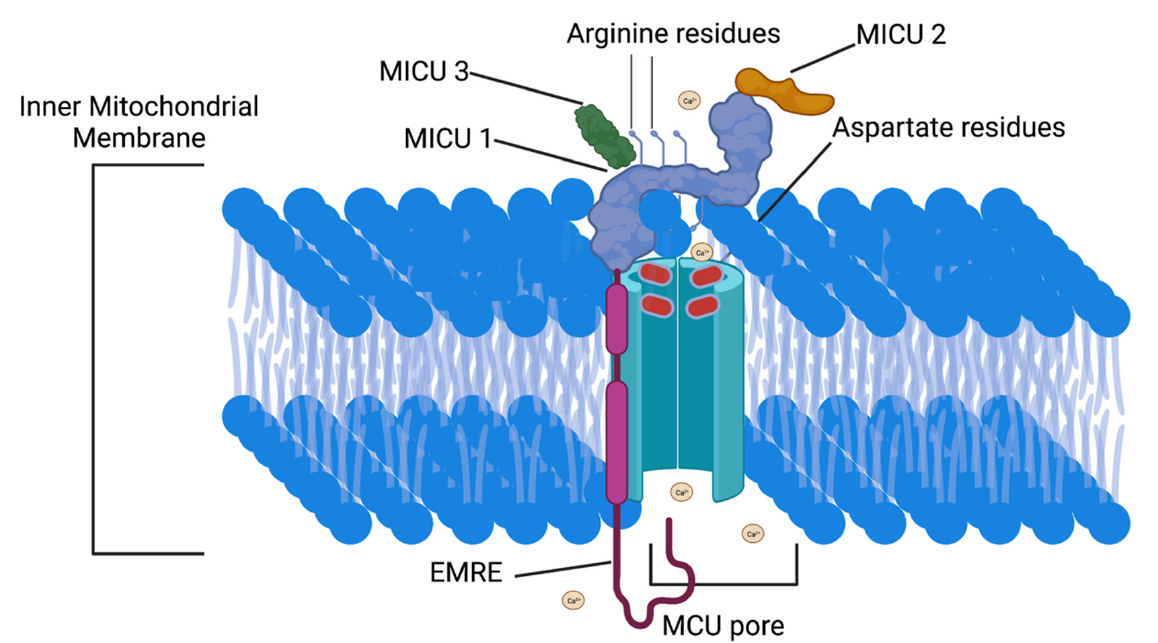
Figure 3. Mitochondrial Calcium Uniporter and MICU1 interaction under high cytosolic Ca 2+ conditions. Under high cytosolic Ca 2+ conditions the MCU complex opens to allow mitochondrial Ca 2+ influx. The MCU complex opens due to interactions between MCU protein aspartate residues and the cytosolic Ca 2+ . When cytosolic Ca 2+ is low the MICU1 arginine fingers bind to the MCU protein aspartate residues and closes the MCU complex. MCU-Mitochondrial Calcium Uniporter, MICU1—Mitochondrial calcium uptake 1. This figure was created with biorender.com.